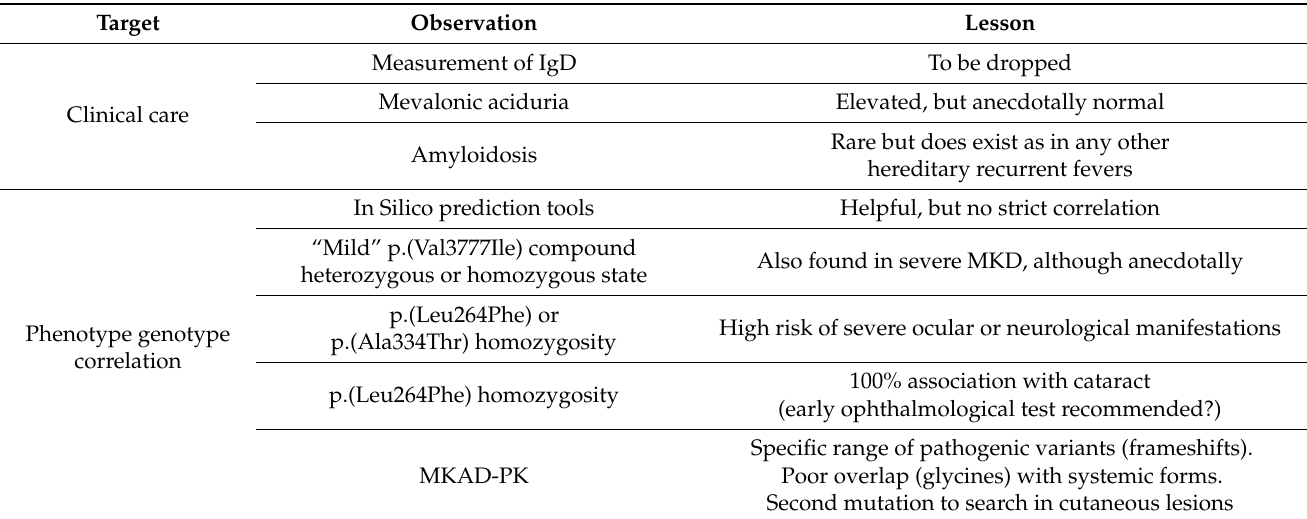
Table 1. Mevalonate kinase-associated diseases take-home